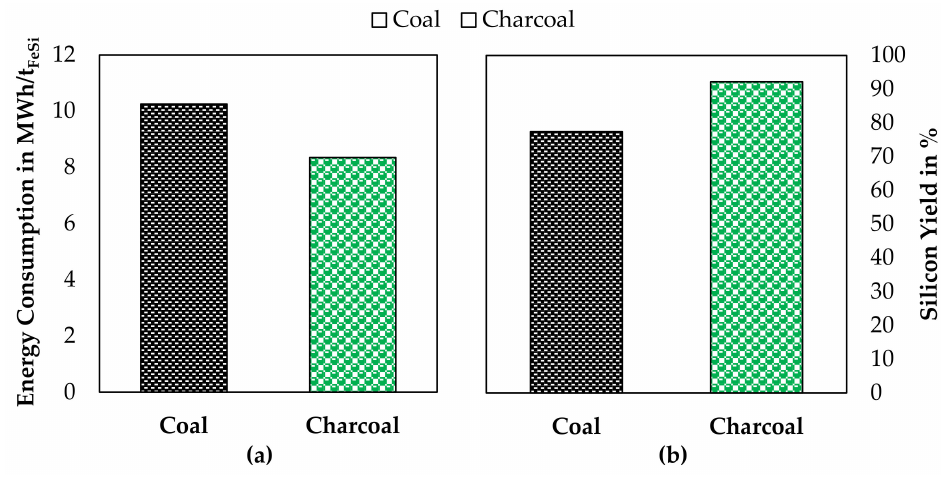
Figure 16. Electrical energy consumption ( a ) and silicon yield ( b ) for the production of FeSi using coal and charcoal (based on data from